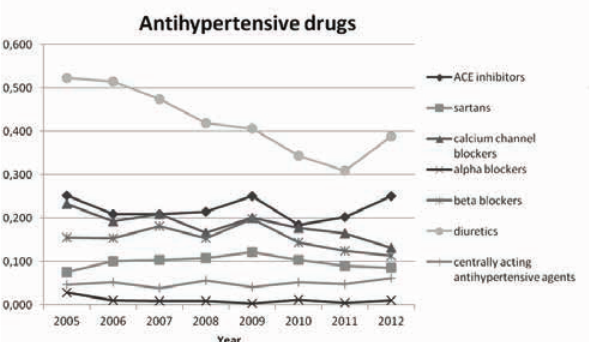
Figure 3: In the treatment of high blood pressure we observed